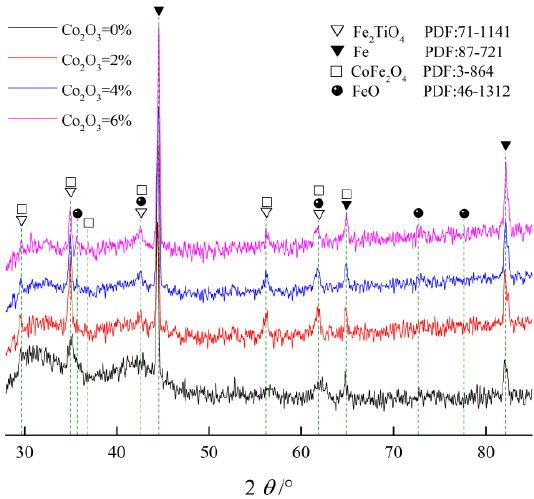
Figure 12. XRD patterns of reduced CVTP with Co 2 O 3 additions.